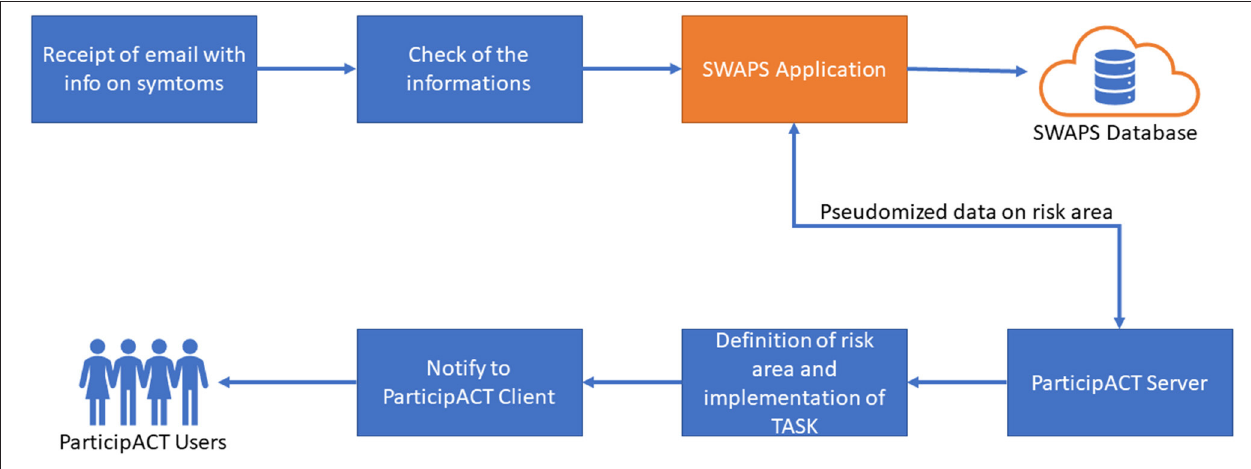
FIGURE 5 | Workflow of SWAPS/ParticipACT